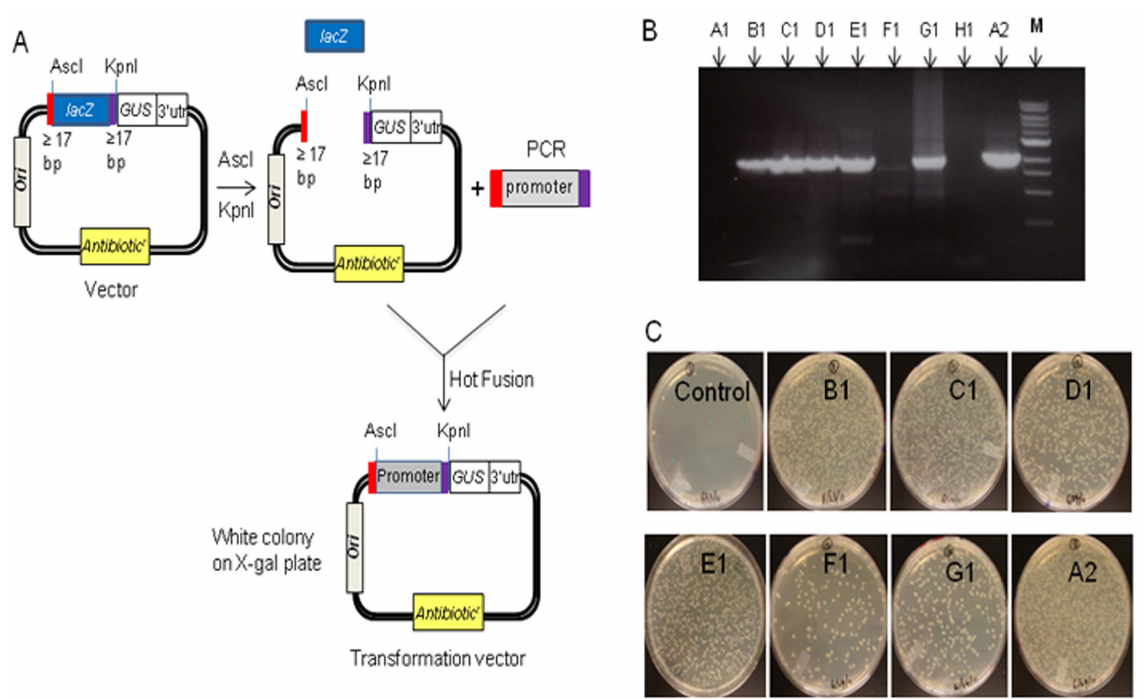
Fig. 3. Single fragment cloning by Hot Fusion. (A) A diagram of single fragment cloning in a binary base vector. Base vector containing a lacZ gene was linearized by restriction enzyme digestion with AscI and KpnI to release lacZ . The linearized vector was directly used for Hot Fusion. (B) Amplified PCR products (A1 through A2) of plant gene promoters were used for cloning. M is a NEB 1 kb DNA ladder. (C) Transformation plates of cloned PCR products (A1 and H1 are not shown). Blue colonies on the plates contain the parental vector and white colonies contain the potential recombinants. Eight white colonies were screened for each construct (Table 2).